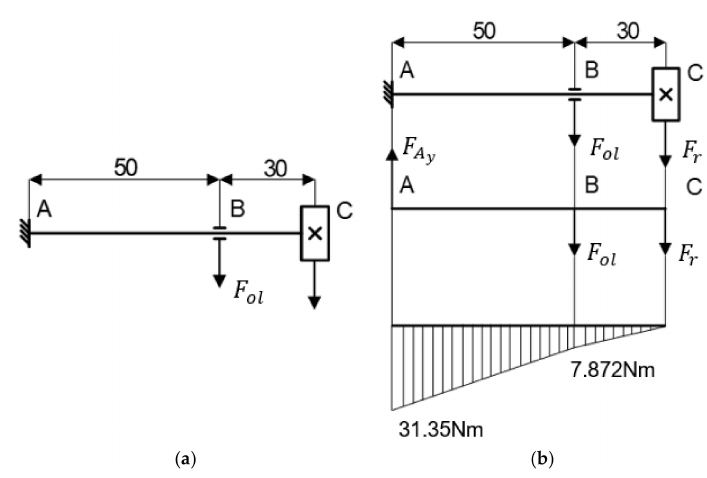
Figure 7. Analysis of joint 1: ( a ) model of forces, ( b ) distribution of moment.